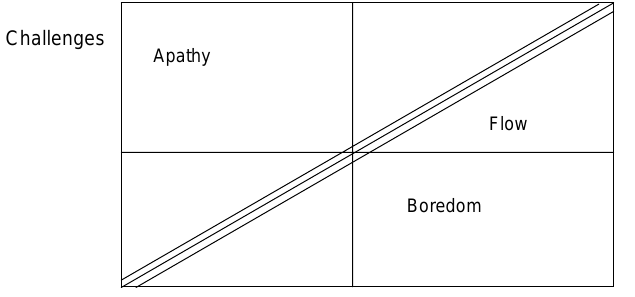
Figure 2: Matching sills and challenges: Flow